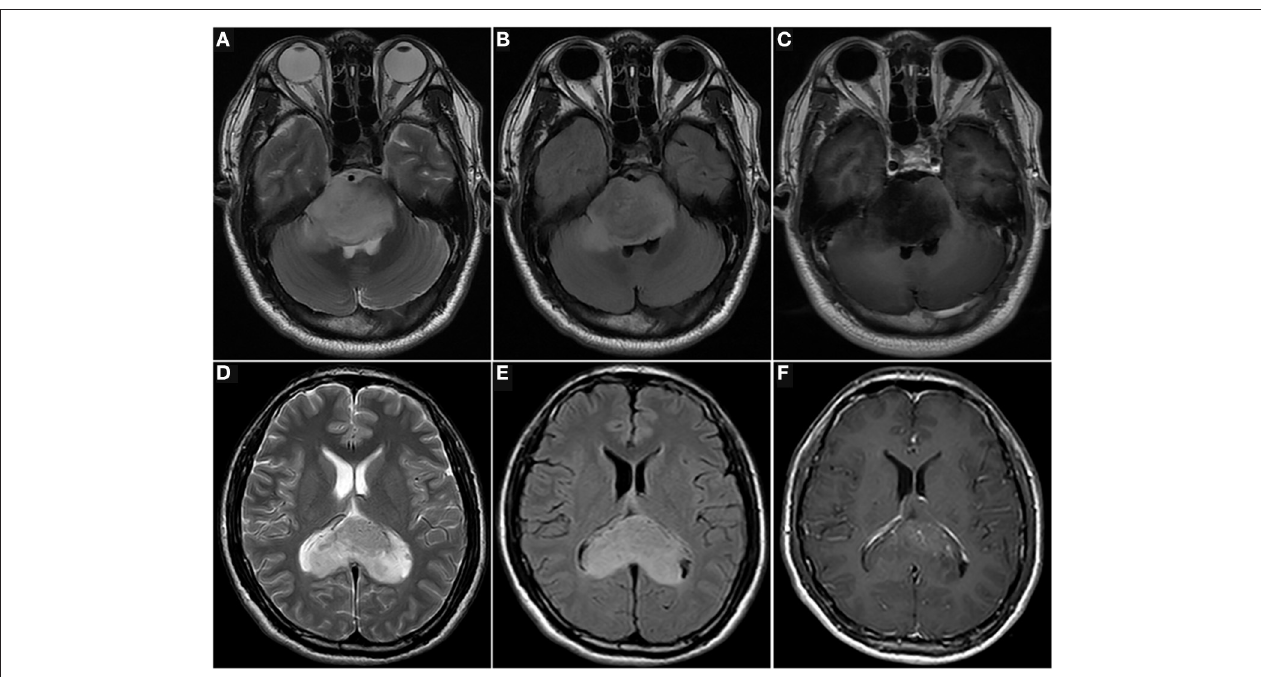
FIGURE 3 | Images of patients with midline gliomas. T2w (A) , T2 FLAIR (B) , and T1c (C) images of a 34-year-old man with a pontine diffuse midline glioma with a H3 K27M mutation (WHO 4), and histopathology of diffuse astrocytoma. He underwent a biopsy and was treated with radiotherapy and chemotherapy. The overall survival of the patient was 4.4 months. T2w (D) , T2 FLAIR (E), and T1c (F) images of a 33-year-old man with corpus callosum diffuse astrocytoma (WHO 2). He underwent a biopsy and was treated with radiotherapy and chemotherapy. The overall survival of the patient was 39 months (up to October